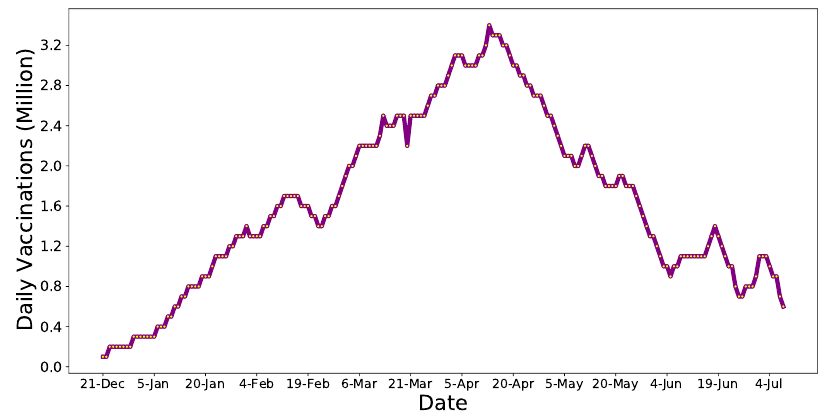
Figure 1. The total number of daily vaccinations (million) in the US (Data source: